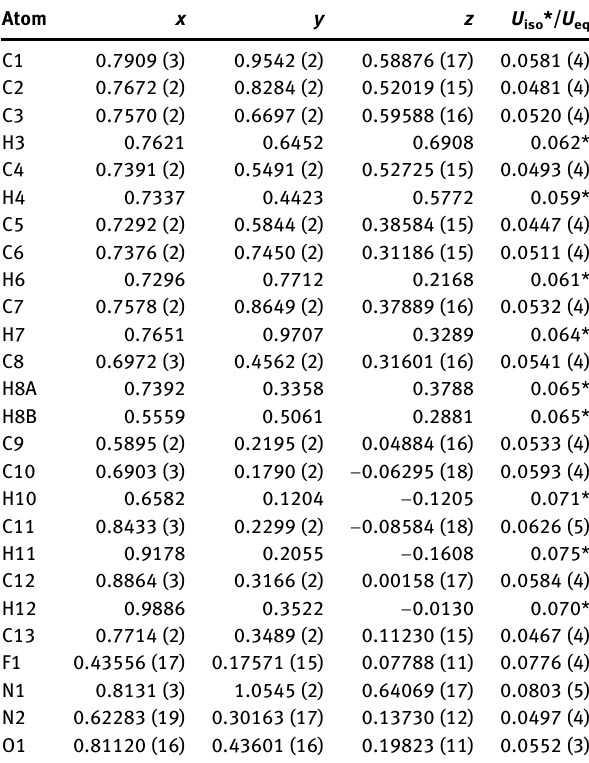
Table  : Fractional atomic coordinates and isotropic or equivalent isotropic displacement parameters (Å 